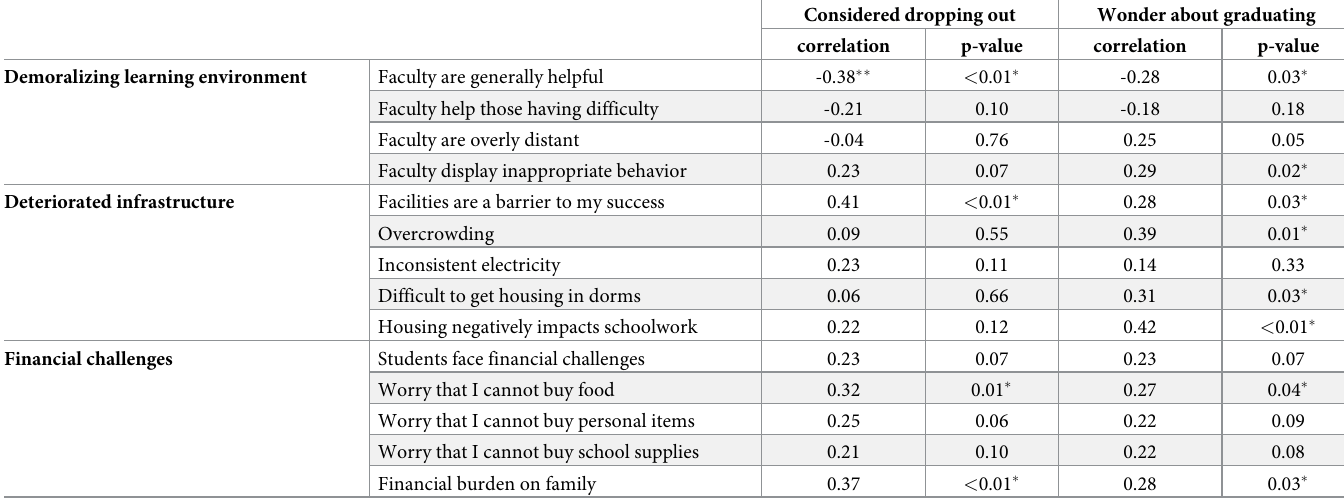
Table 6. Relationship between AMD medical students’ experiences and their concerns about completing medical school (2016).